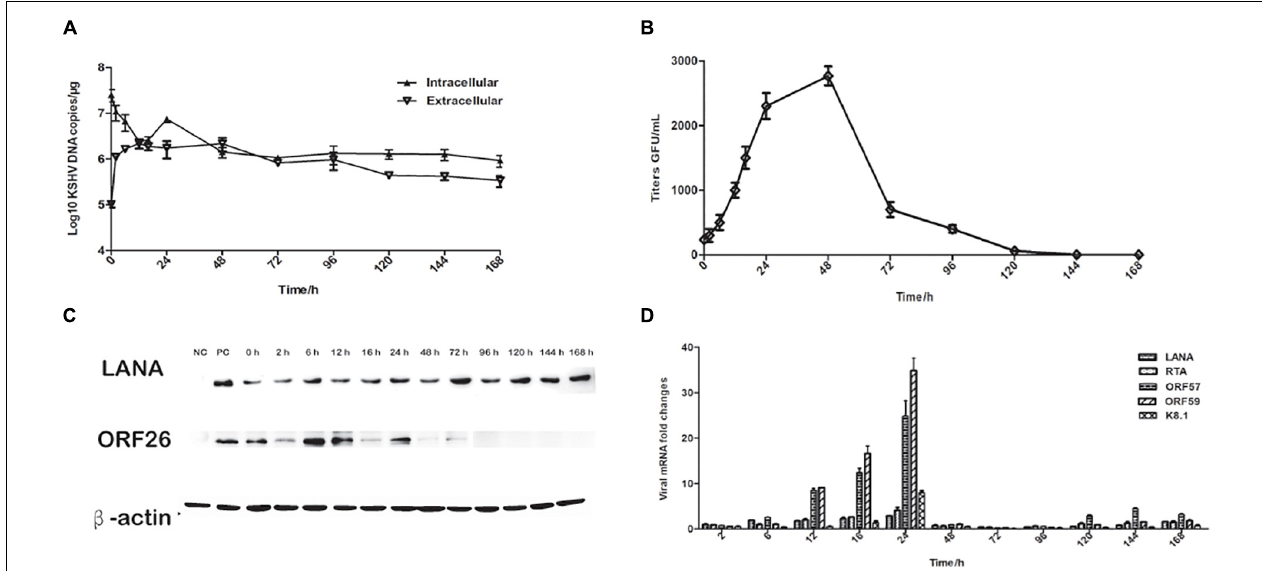
FIGURE 2 | Characteristics of rKSHV.219 entry into the infected TSKEC (MOI = 10). (A) Intracellular and extracellular rKSHV.219 genome copies in TSKEC. (B) Titer of rKSHV.219 in TSKEC. (C) RT-q-PCR of rKSHV.219 transcripts in TSKEC. (D) The expression of KSHV LANA and lytic ORF26 proteins in TSKEC.